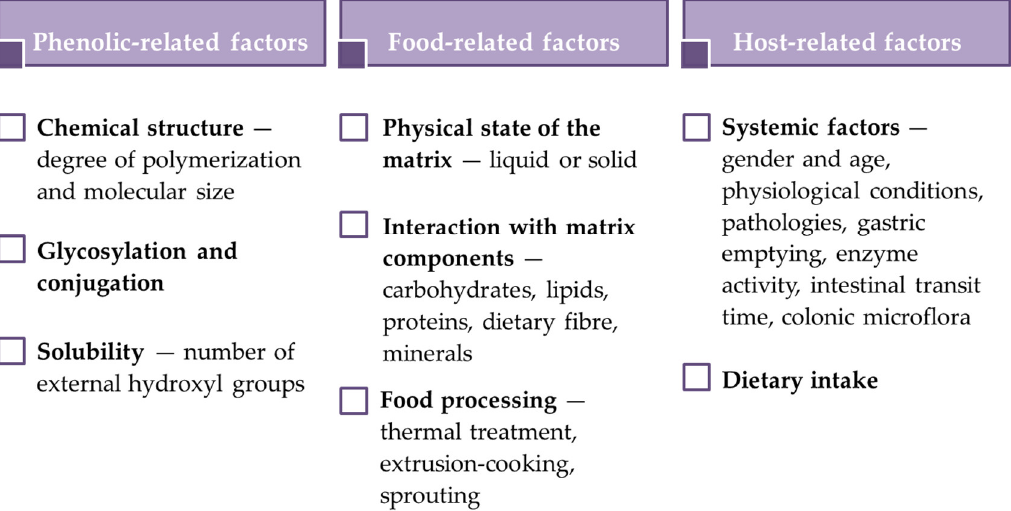
Figure 1. Factors a ff ecting bioaccessibility and bioavailability of phenolic Figure 1. Factors affecting bioaccessibility and bioavailability of phenolic compounds.